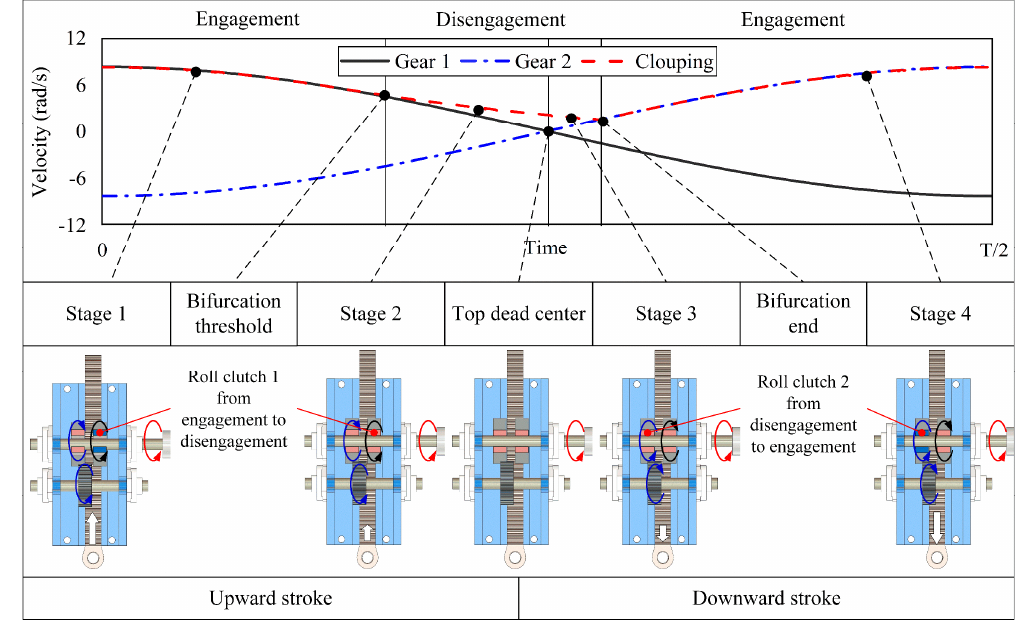
Figure 2. Process of motion bifurcation under harmonic excitation.